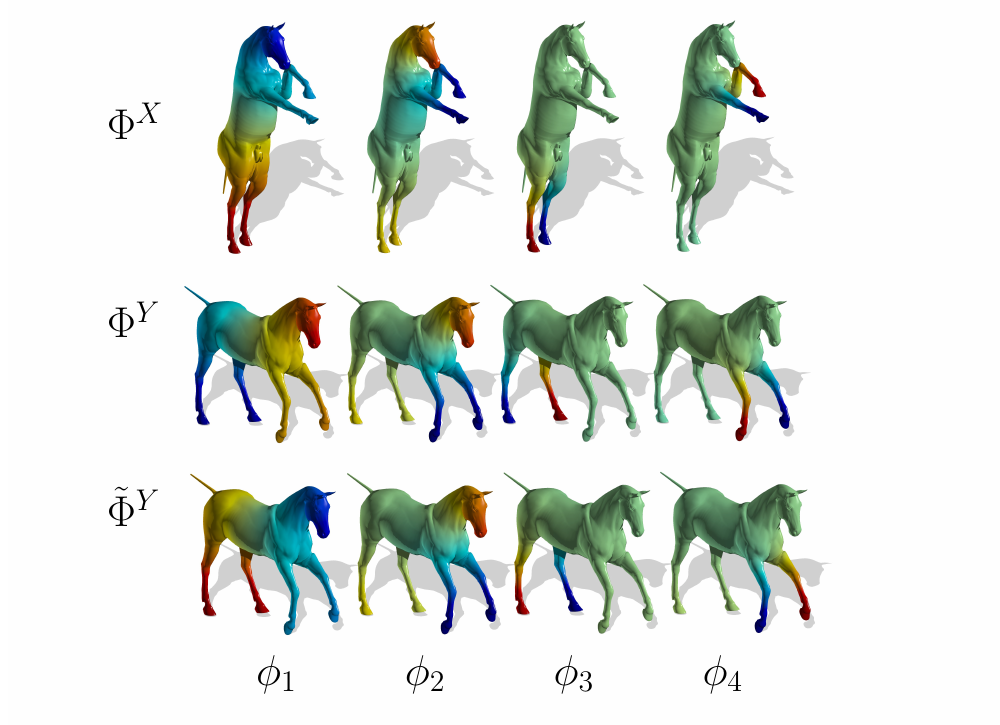
Figure 5. Eigenfunction matching of two nearly isometric shapes. Hot and cold colors represent positive and negative values, respectively. ( Top ) The first pose of a horse; ( center ) the second pose of a horse; ( bottom ) the second pose of a horse after the matching algorithm.